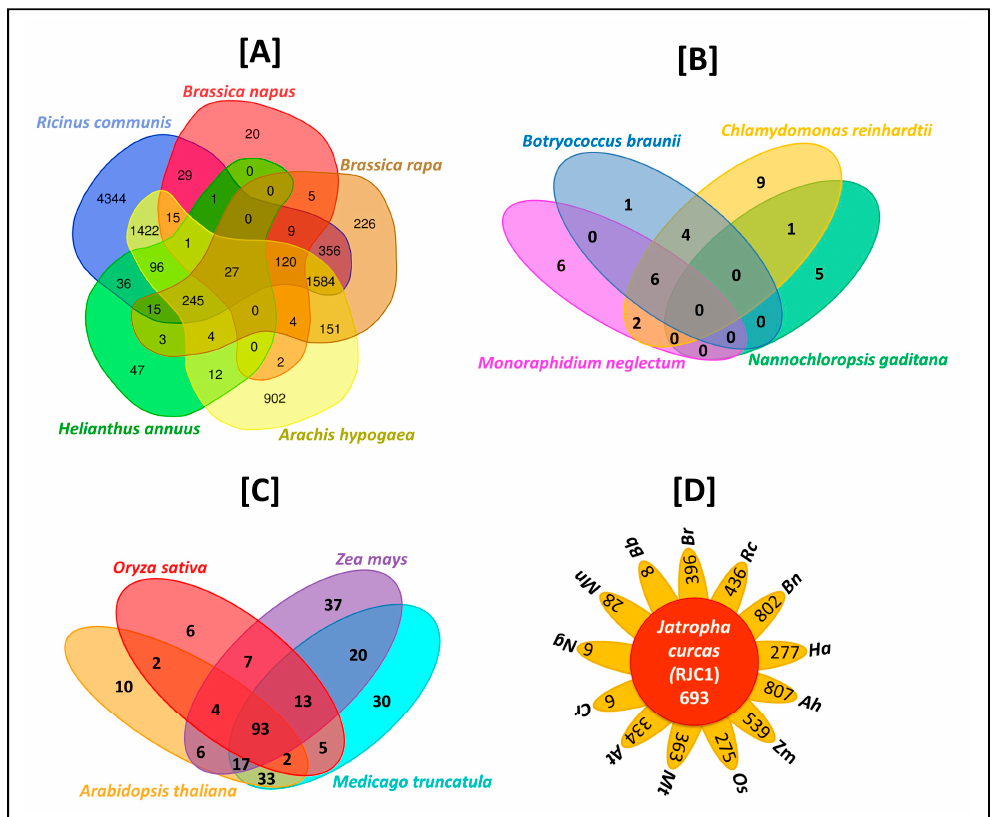
Figure 5. Venn diagrams depicting the comparative analysis for 693 conserved lipid-metabolizing genes of J.curcas between ( A ) Oil-producing plants ( Brassica napus : Bn; Brassica rapa: Br ; Arachis hypogaea : Ah ; Helianthus annuus : Ha , and Ricinus communis : Rc ); ( B ) Oil-producing algae ( Botryococcus braunii : Bb ; Chlamydomonas reinhardtii : Cr ; Monoraphidium neglectum : Mn , and Nannochloropsis gaditana : Ng); ( C ) Model plant species ( Oryza sativa : Os ; Zea mays : Zm ; Medicago truncatula : Mt , and Arabidopsis thaliana : At ). Plot; ( D ) shows the 13 plant species having gene conservation with 693 RJC1 lipid-metabolizing genes. The middle circle depicts a total of 693 RJC1 lipid-metabolizing genes, and leaves depicts the individual gene numbers of each of the 13 plant species.